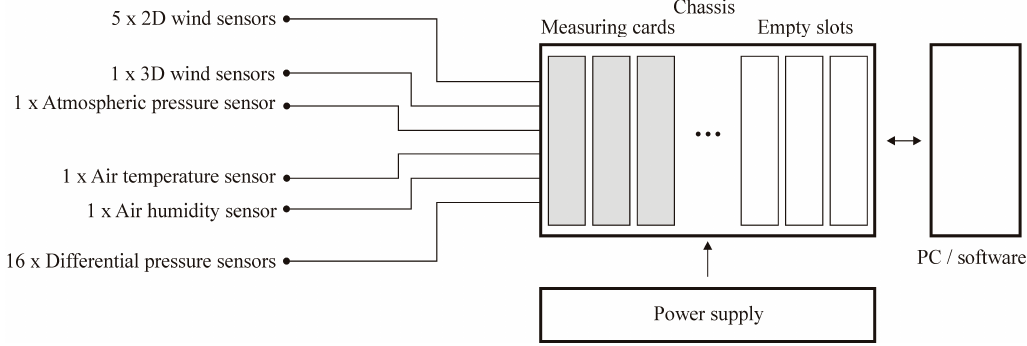
Figure 1. Measuring system configuration.